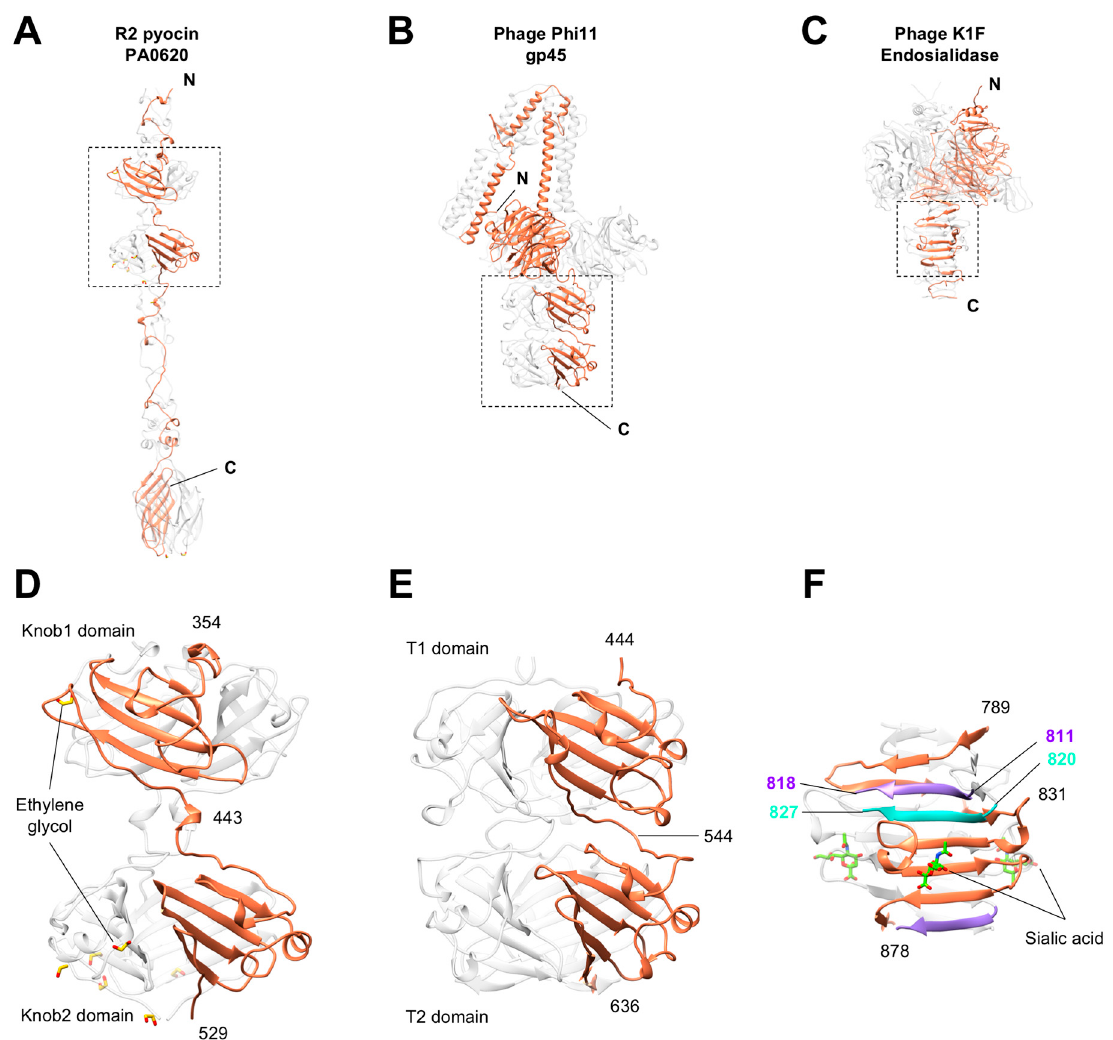
Figure 5. Comparison of the Knob domains with their orthologs from other receptor-binding proteins. Location of the Knob-like domains in the pyocin fiber ( A ), in the putative receptor-binding protein gp45 of phage phi11 [65], and ( B ) in the endosialidase tailspike of phage K1F (where it is called β -prism) [66,67] ( C ). The dashed-line rectangles outline the area of detail shown enlarged in panels ( D – F ). Each face of the Knob-like β -prism of the K1F endosialidase (panel F ) is composed of three polypeptide chains (three different colors). The β -prism forms a smooth extension of the triple-stranded β -helix domain.